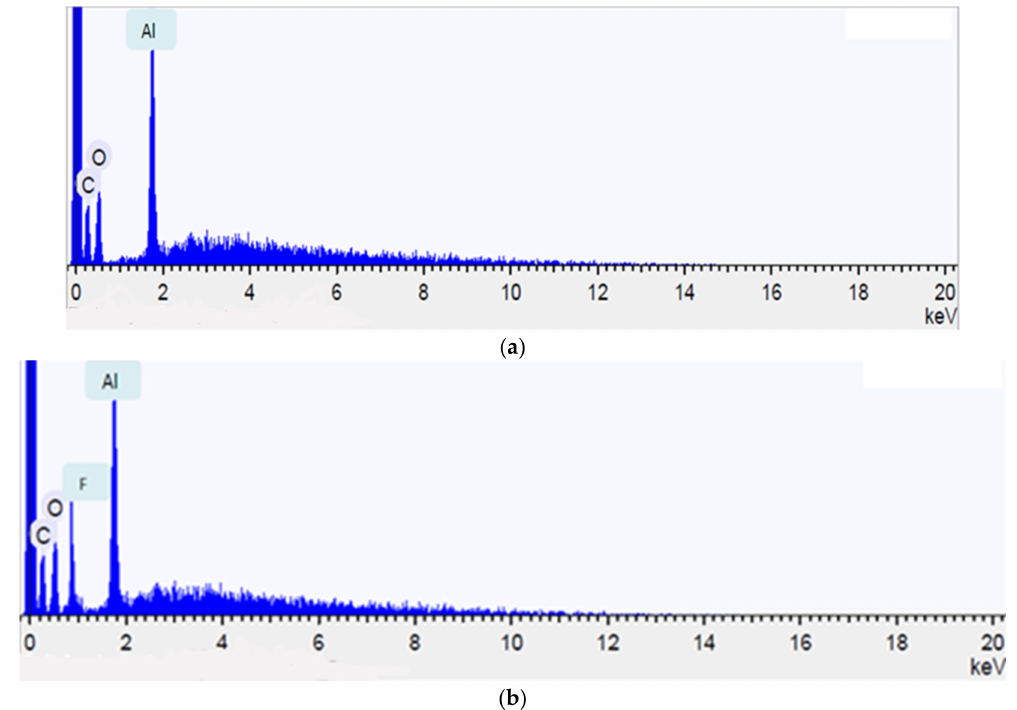
Figure 8. Diagram of the elemental distribution of the sample ( a ) before and ( b ) after sorption, obtained by the EDS method at an accelerating voltage of 15